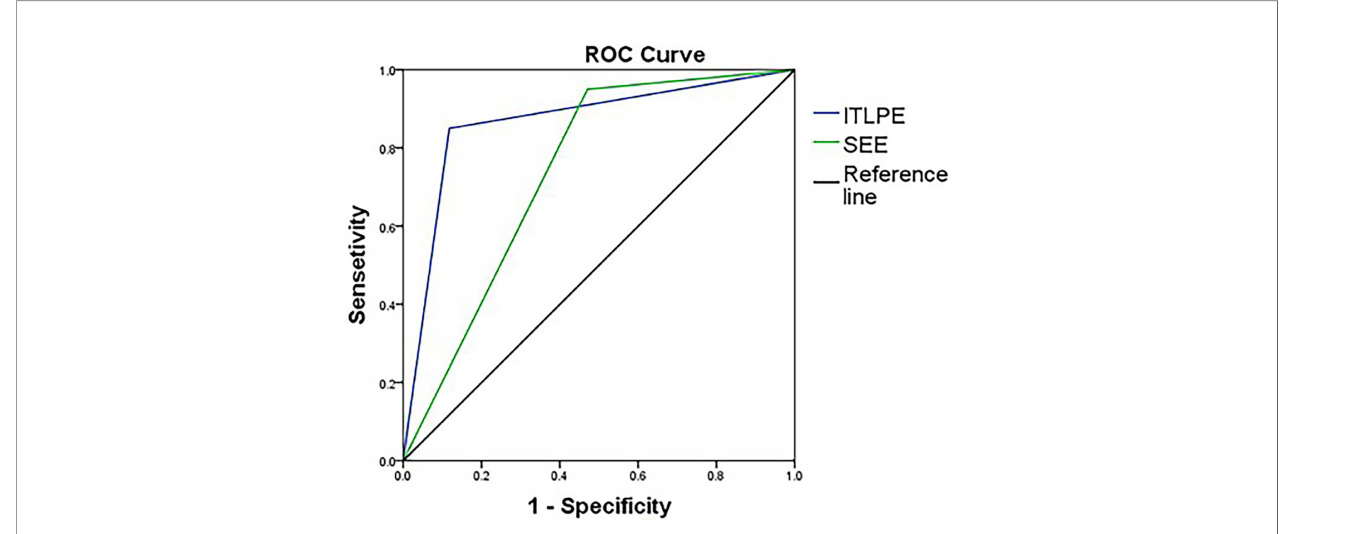
FIGURE 4 | Receiver operating characteristic curve of SEE and ITLPE for myometrial invasion in patients with low-risk endometrial carcinoma.